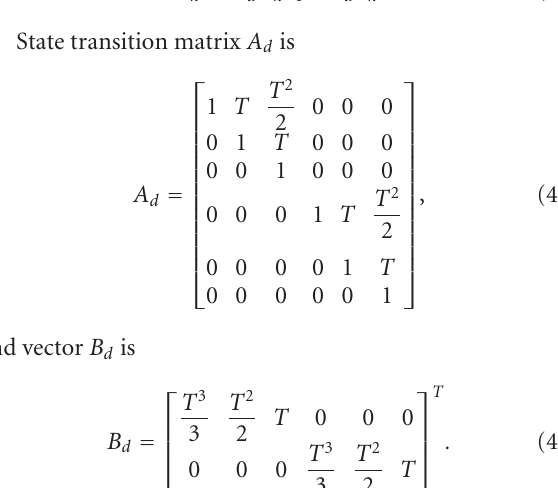
Figure 4: Target track and estimation of probability of distribution in next time step using Monte Carlo simulation.